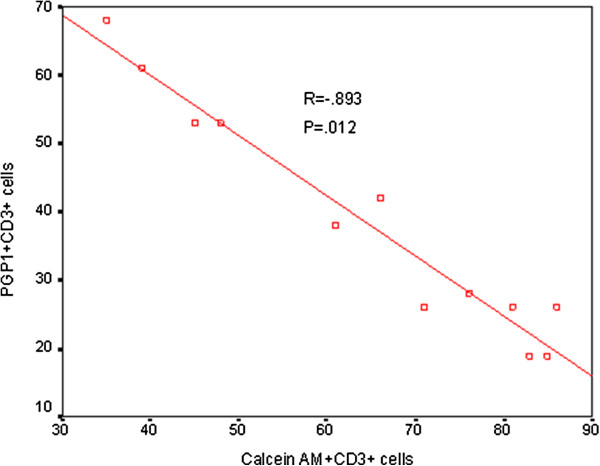
Correlation between Calcein-AM and Pgp1 in T cells. Graph of Calcein-AM + CD3+ versus Pgp1 + CD3+ T cells. There was a significant negative correlation between Pgp1 expression and Calcein-AM uptake by CD3 + T cells from a cohort of 6 COPD patients and 6 control subjects.